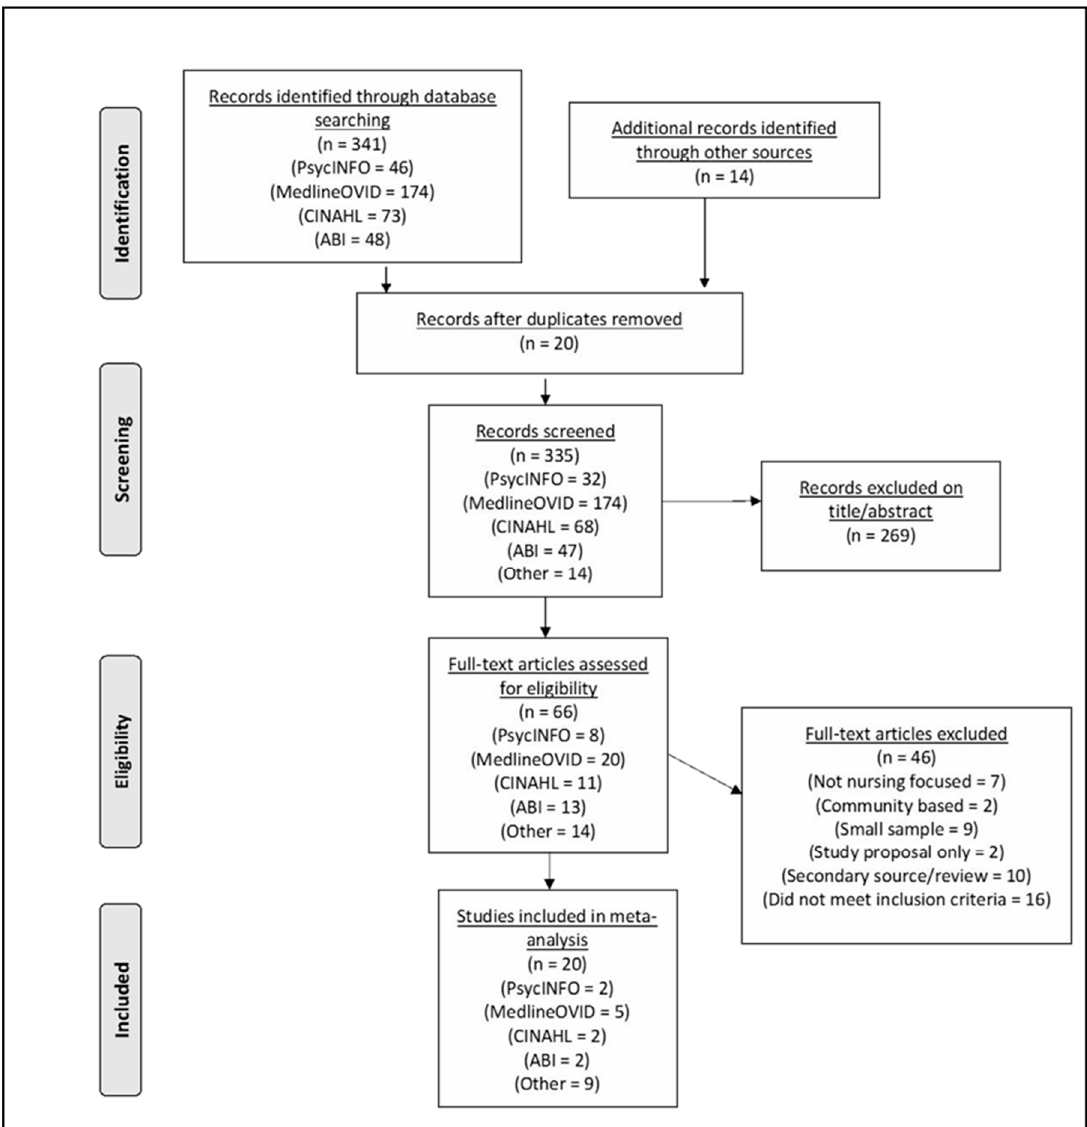
Figure 1. PRISMA flow diagram.